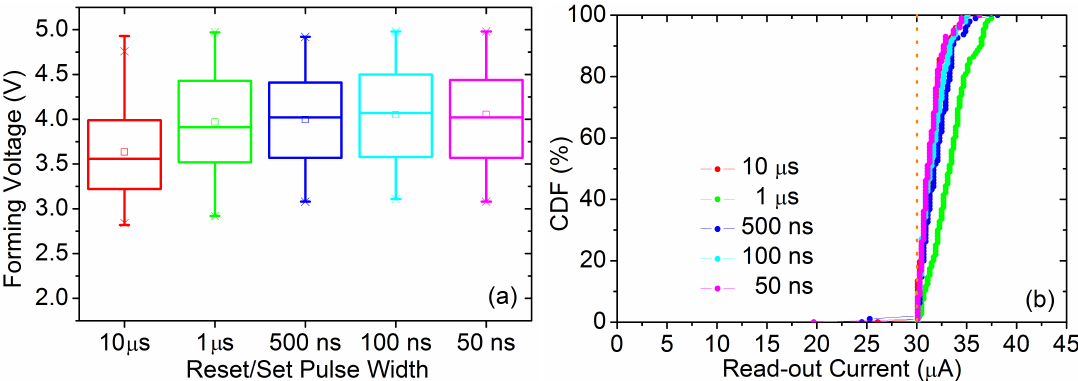
Figure 2. Box plots of forming voltages ( a ) and cumulative distribution functions (CDFs) of the currents measured just after the set transition ( b ) for the initial programming stage. Every box/CDF refers to one batch of 128 RRAM devices labeled with the pulse width value employed for the reset/set